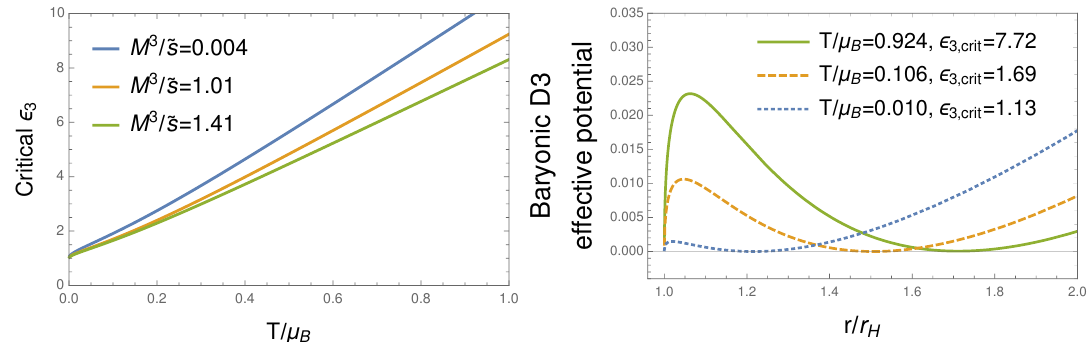
Figure 8 . Left: the critical value of (cid:15) 3 where baryon condensation could occur for the ( m 1 ; m 2 ) = (0 ; 1) wrapping, as a function of T=(cid:22) B , for increasing values of M 3 normalized by ~ s (cid:17) G 5 s , where s is the entropy density. Right: the baryonic potential along the M 3 = ~ s = 1 : 41 curve on the left. this indicates that no condensation occurs throughout the accessible phase diagram, even in the zero temperature limit. Furthermore, the extremal T = 0 geometry appears to be marginally stable: there is a minimum right by the horizon, which for any (cid:15) dip below zero leading to an